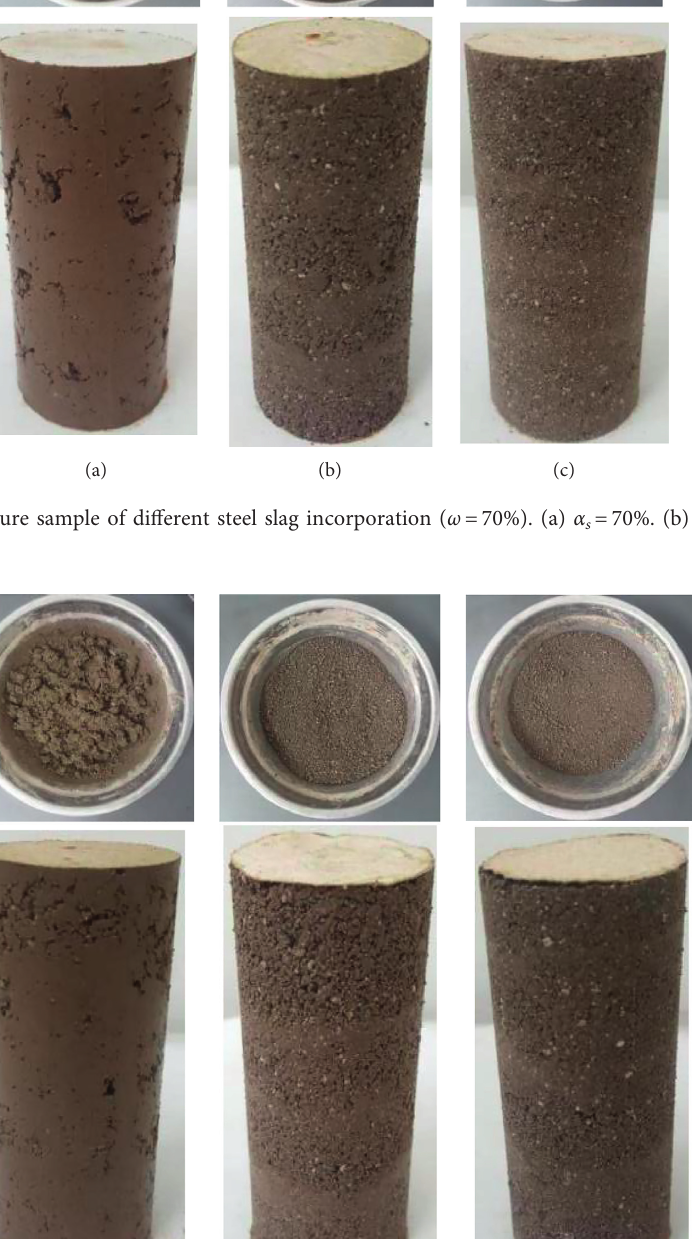
� 70%. (b) α � 90%. (c) α � s s s